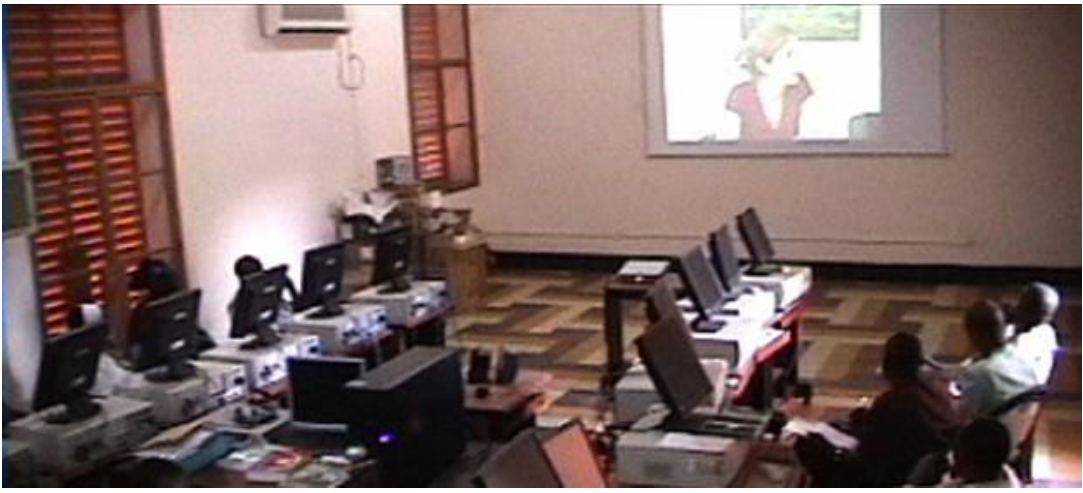
Figure 2 . A partial view of the DE classroom setting at the UNFM-Bamako in